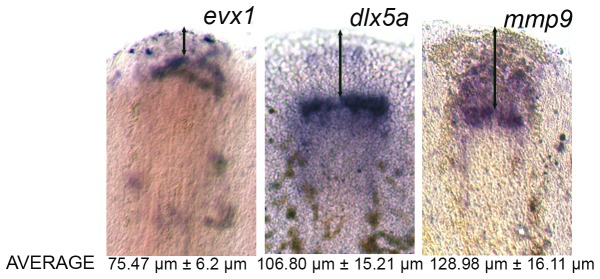
Expression domains of joint genes expressed during fin regeneration.The double arrow identifies the measured distance between the expression domains and the distal tip of the fin. The measurement was taken from the third ray of each fin and the average and standard deviation (±) were calculated.